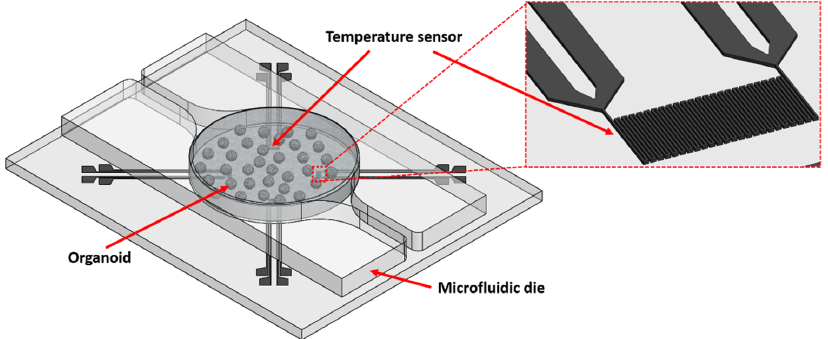
Figure 1. Schematic representation of the temperature sensors integrated in the organ-on-a-chip.